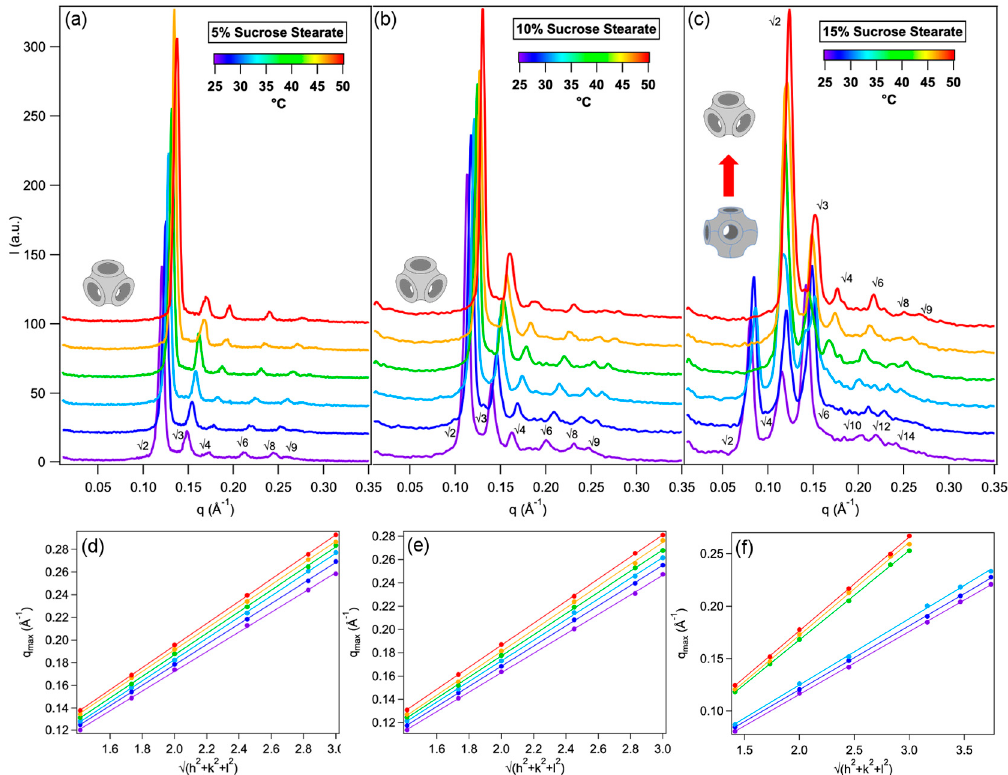
Figure 1. Structure of Phyt mesophases doped with SS. SAXS profiles of Phyt mesophases containing 5% ( a ), 10% ( b ) and 15% ( c ) w / w SS, in excess water, measured at 25, 30, 35, 40, 45, 50 °C. ( d ), ( e ) and ( f ) show the linear plots of the Bragg peaks q-values vs. h, k, l indices, to estimate the lattice parameters of the mesophases with 5%, 10% and 15% SS, respectively. Table 1. Lattice parameter d (nm) of Phyt mesophases doped with different concentrations (0%, 5% w / w , 10% w / w , 15% w / w ) of SS in excess water, measured at different temperatures in the range T = 25–50 °C.